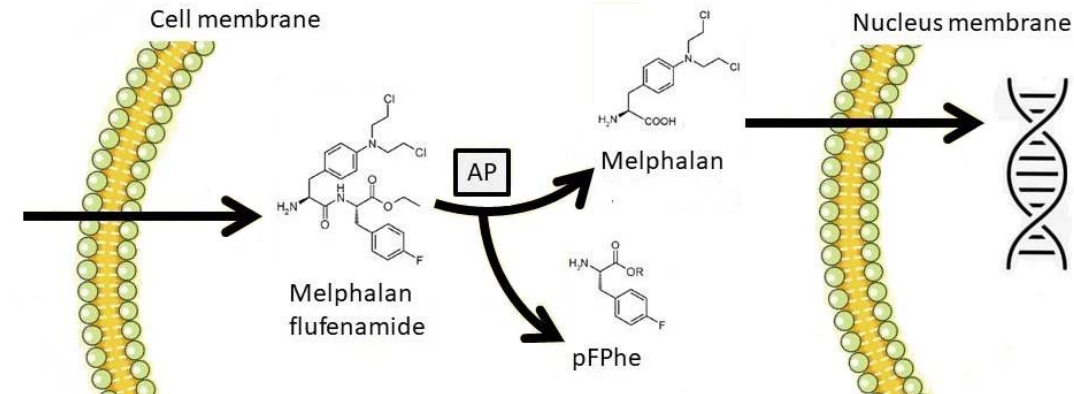
Figure 2. Melphalan flufenamide (melflufen) diffuses rapidly through the cellular membrane due to its lipophilic properties. Cytoplasmic aminopeptidases (AP) cleave melphalan from its peptide carrier (pFPhe). The hydrophilic melphalan residue is trapped into the cell and exerts its alkylating effect in the